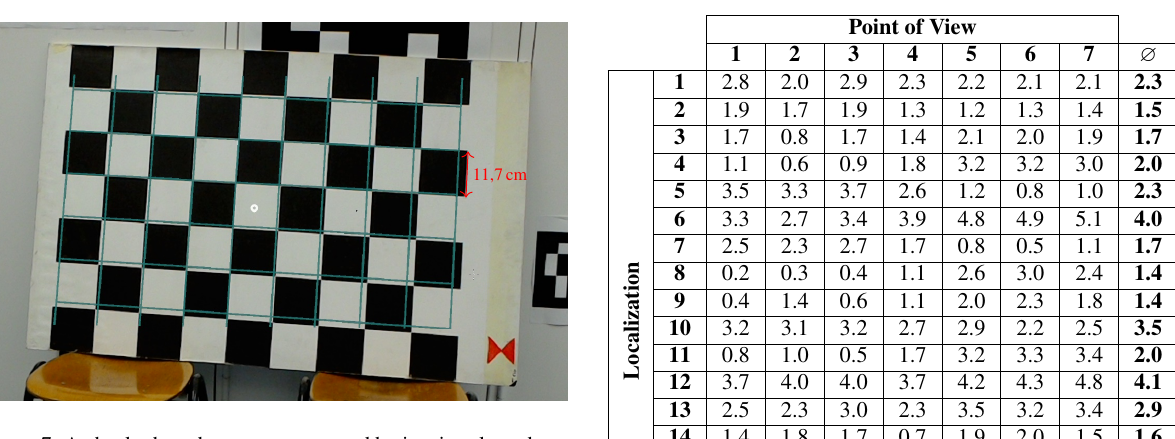
Figure 7. A checkerboard pattern augmented by its virtual pendant in blue. The increasing offset between the virtual and real pattern with distance from the position of the HoloLens cursor only ap- pears in the images captured with the HoloLens "Live Capture" camera. The user wearing the device perceives an overall correct overlay.